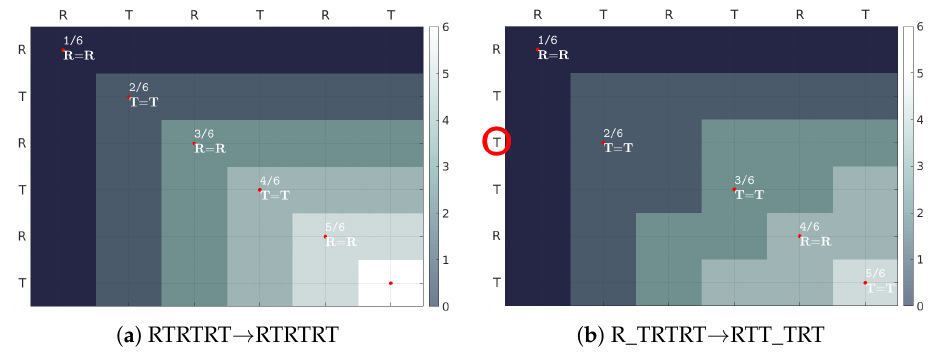
Figure 7. NW coefficient for two series of 6 characters: ( a ) identical/correct, NW = 100%, ( b ) incorrect ≈ 83%. Parameters: match bonus = 1, mismatch/gap penalty = NW = 5 6